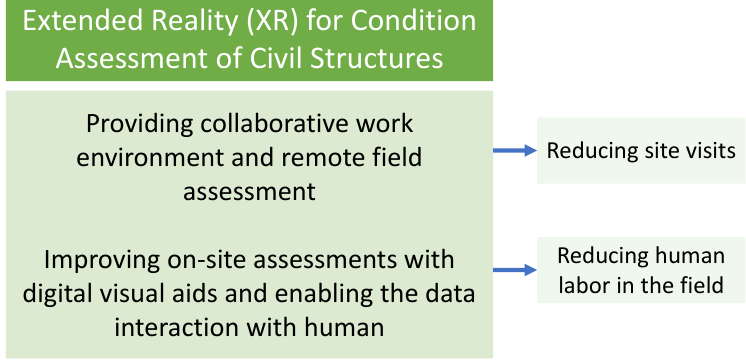
Figure 24. Highlights observed in XR studies presented in this paper.